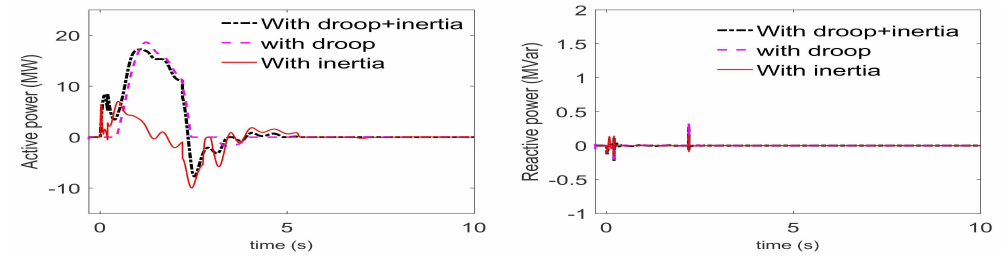
Figure 12. The active and reactive power of BESS with the generation event.